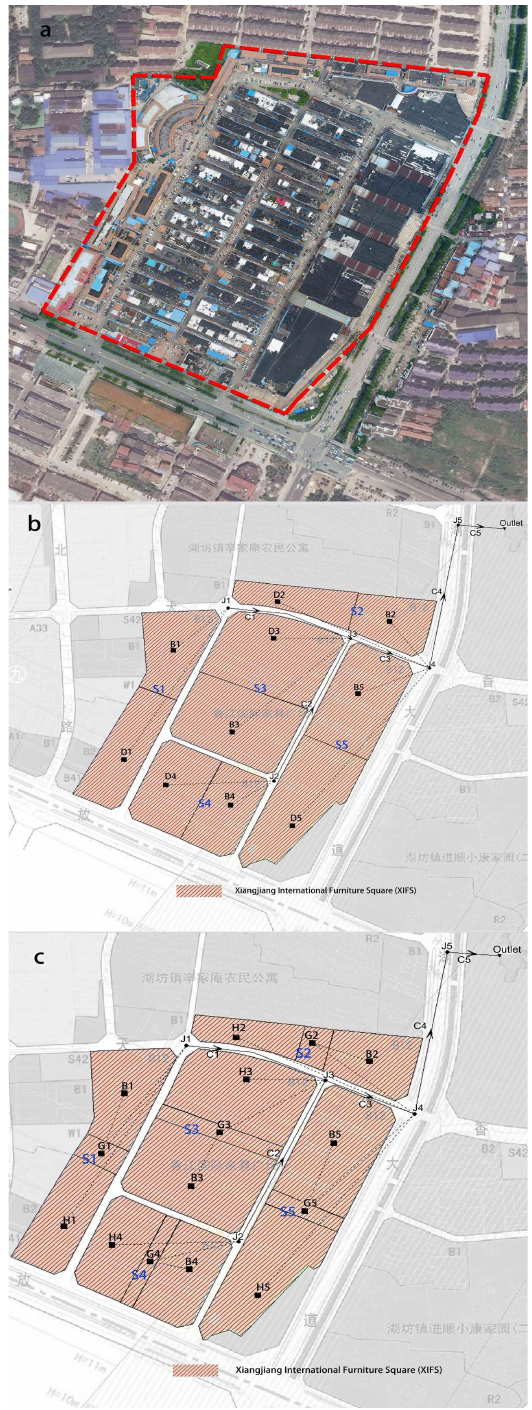
Figure 3. Map of the study site. ( a ) The aerial photograph of the Studying District (Xiangjiang International Furniture Square (XIFS)); ( b ) division diagram of XIFS catchment for the comparison between the Traditional Roof System (TRS) and the Green Roof System (GRS); ( c ) division diagram of XIFS catchment for the comparison between the GRS and Improved Green Roof System (IGRS).